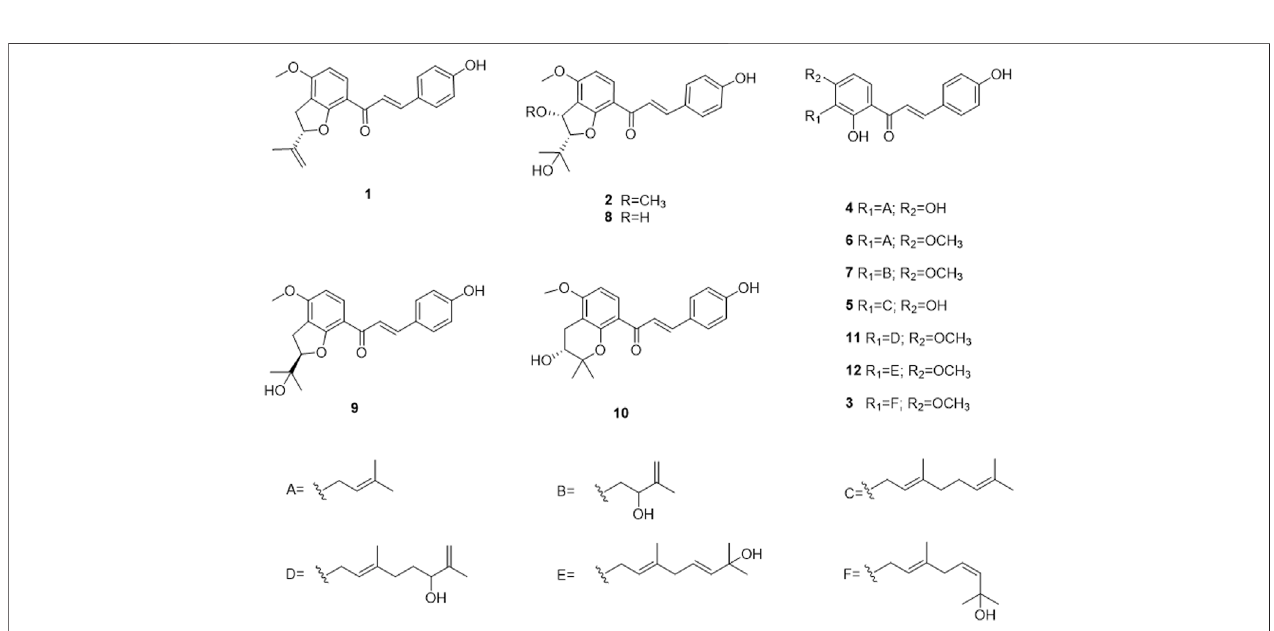
FIGURE 2 | The chemical structures of compounds 1 – 12 isolated from seeds of Abelmoschus manihot.